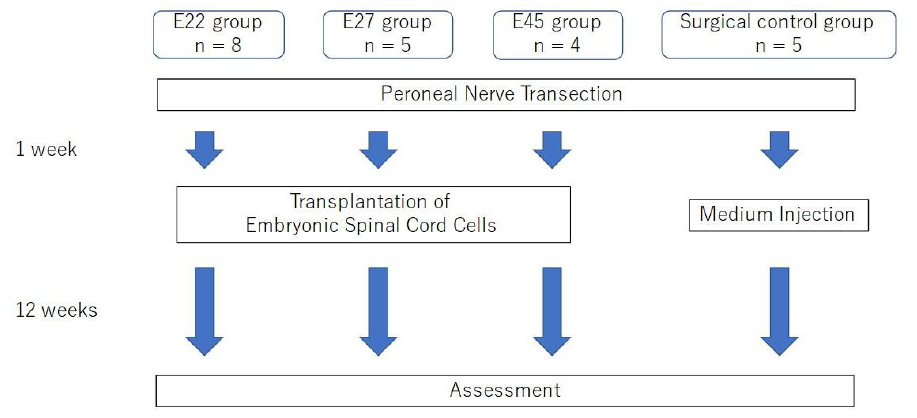
Figure 9. Flowchart depicting the timeline and steps for cell preparation and